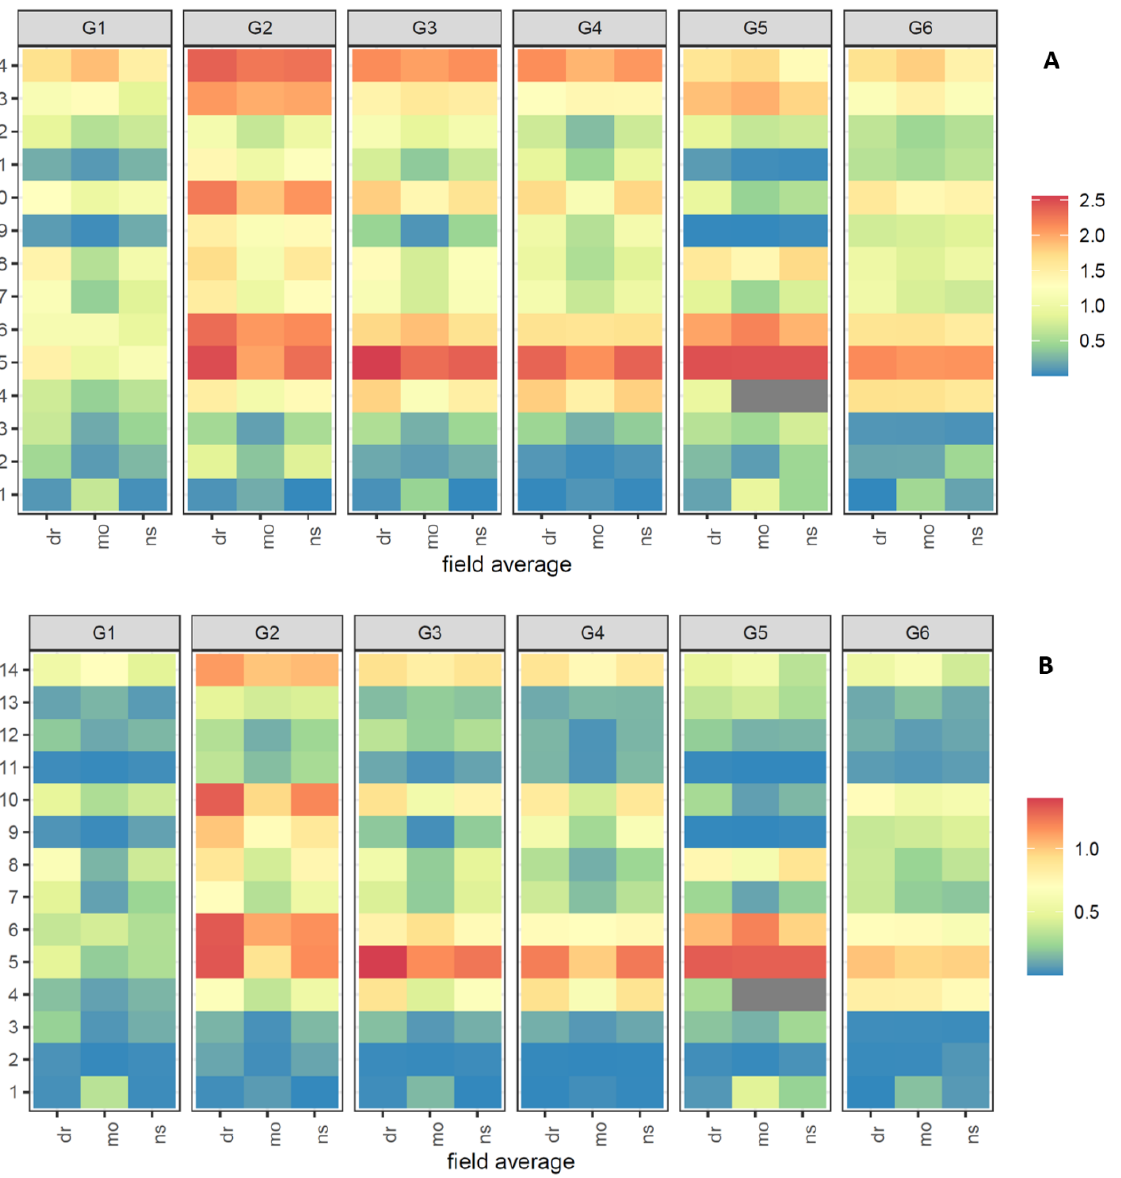
ple, caused by the low DoTs, the carrot “Texto” should be used for future cultivation and breeding studies when water stress is expected; in contrast, its opposite, G2, highlighted the highest DoT factors. The genotypes G3 and G4 also clearly displayed DoT above one, followed by G5 and G6. Future perspectives dealing with the bitter taste of carrots should